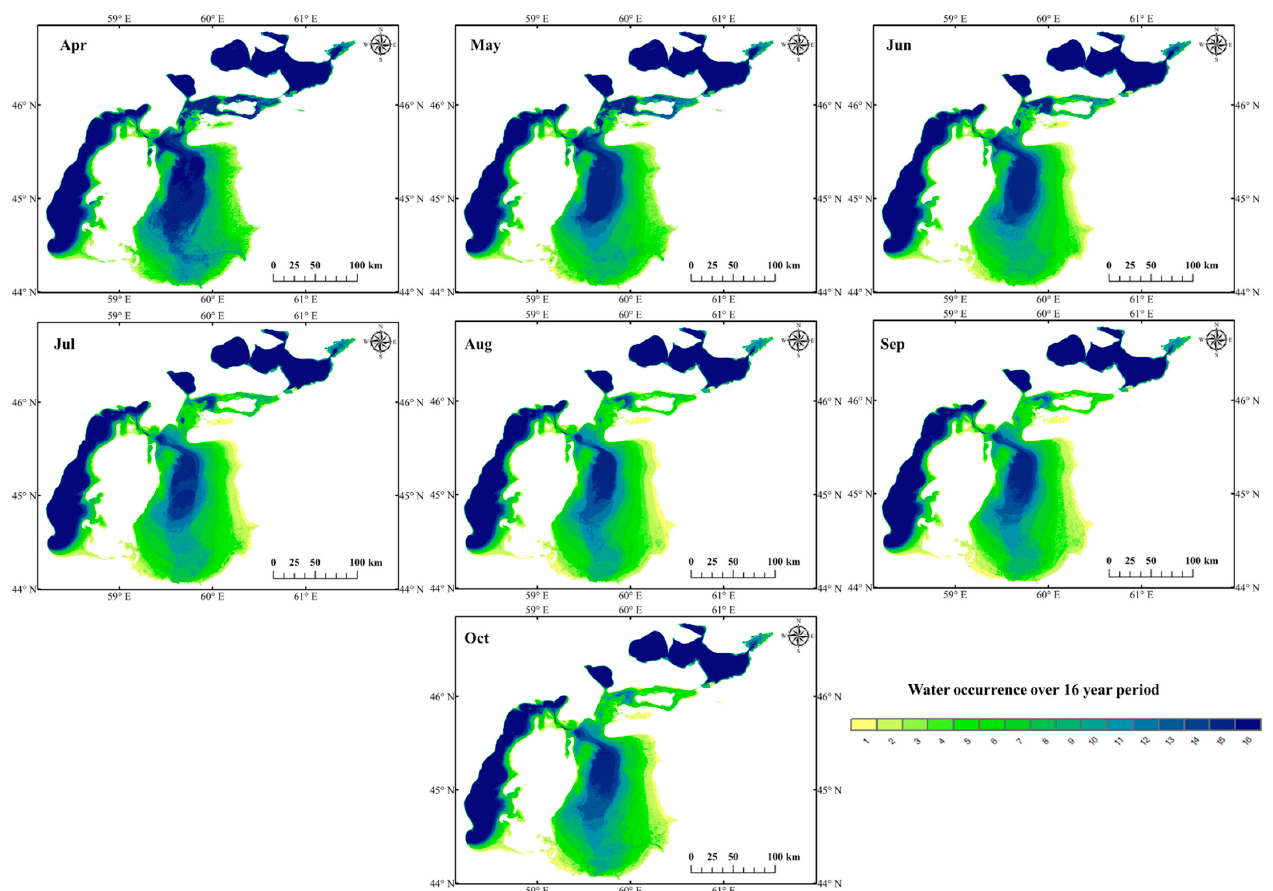
Figure 10. Monthly dynamics of water bodies for the Aral Sea over 16-year study period.